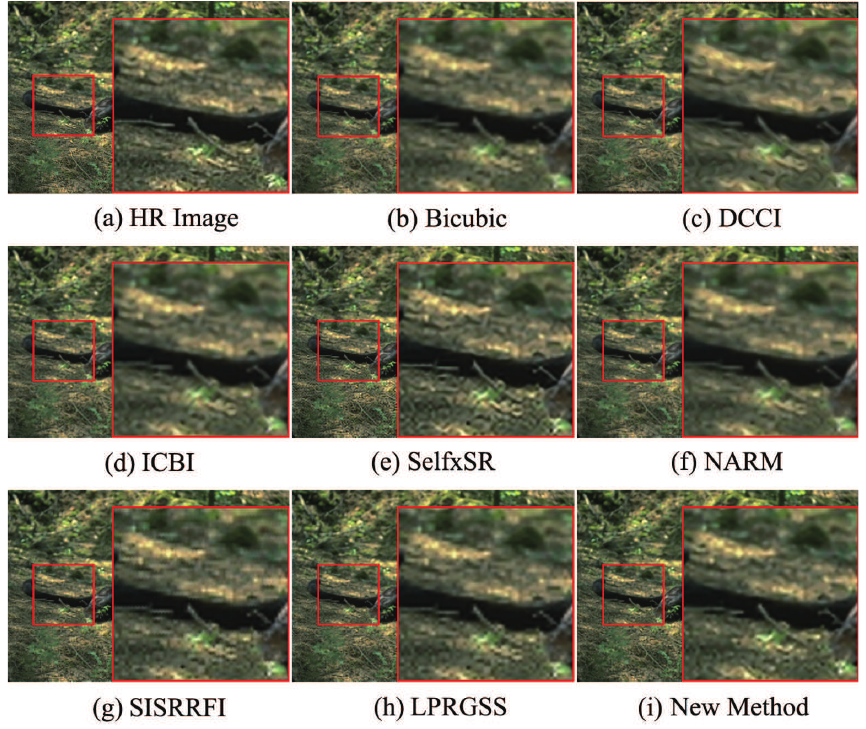
Figure 6. Branch images magnified by eight